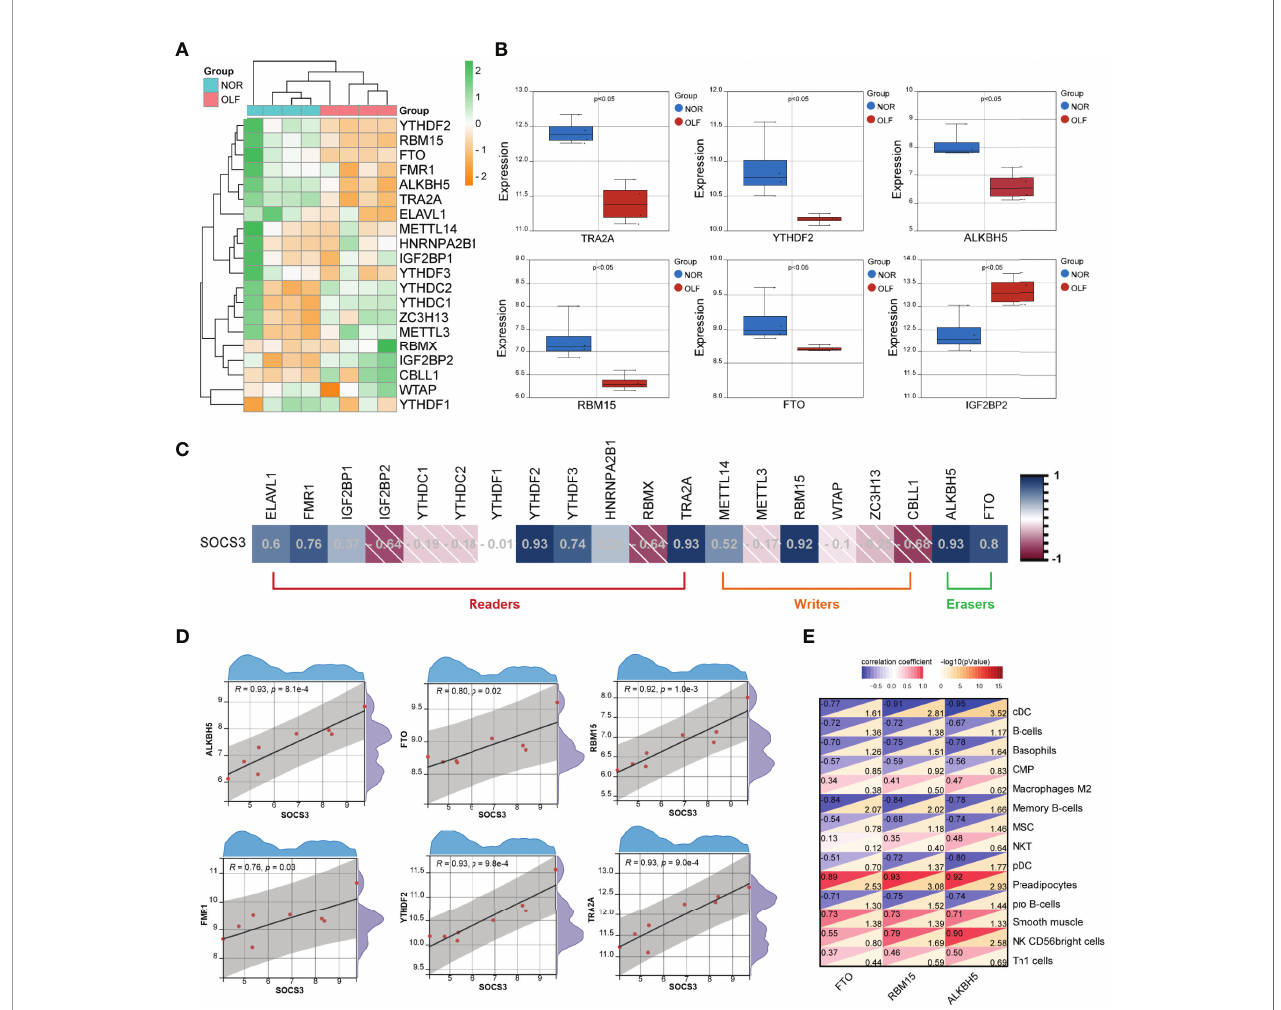
FIGURE 8 | Correlation analysis of SOCS3 and m6A RNA methylation regulators in OLF. (A) Heatmap of 20 m6A regulators in OLF. (B) Box plot showing six differentially expressed m6A regulators (TRA2A, YTHDF2, RBM15, IGF2BP2, FTO, and ALKBH5) between OLF and control tissues. (C) Correlation heatmap between SOCS3 expression and 20 m6A regulators. (D) SOCS3 expression was signi fi cantly positively correlated with 6 m6A-related genes, including FTO, YTHDF2, RBM15, FMR1, ALKBH5, and TRA2A. (E) Correlation heatmap between these three m6A modi fi ers (FTO, RBM15, and ALKBH5) and